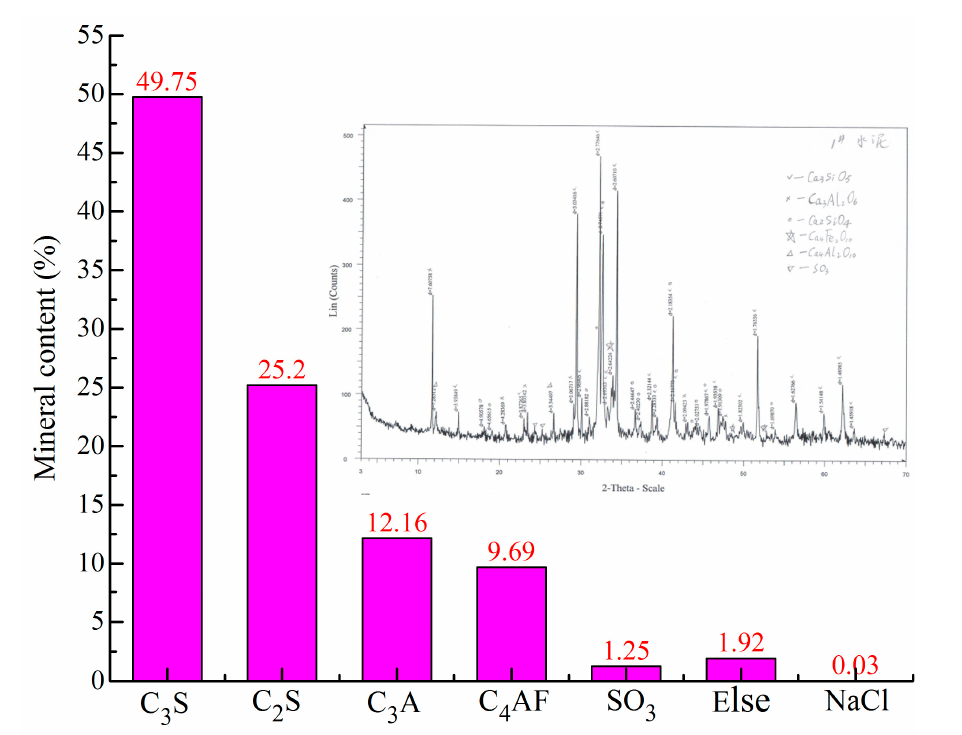
Figure 1. Mineral composition and content of cement.